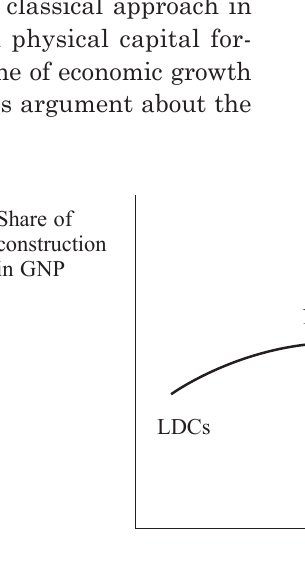
figure 1. Share of construction in GnP versus GnP per capita (Bon, 1992)